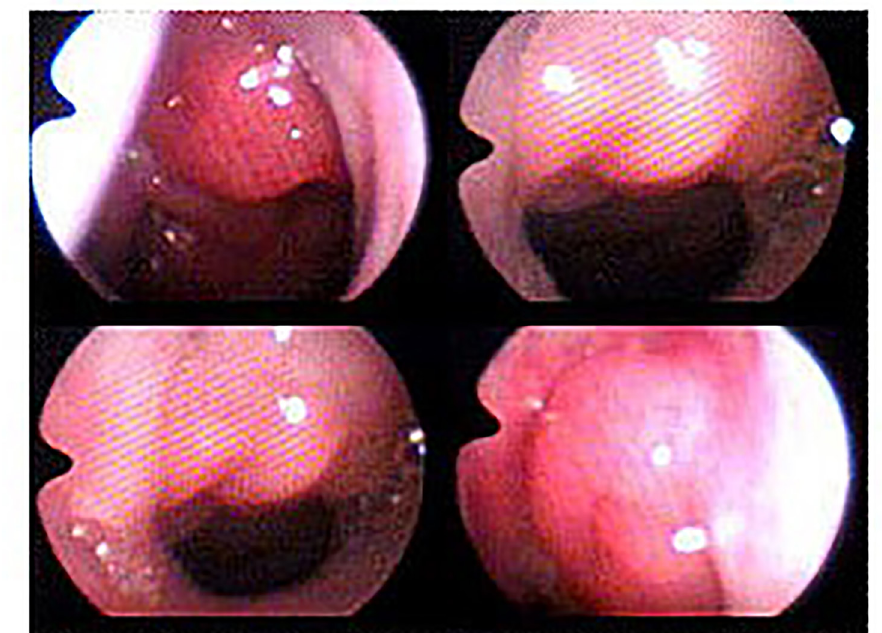
Figure 2 - Choana nasal endoscopic view – Grades I (up to 25% of choana obstruction), II (25% to 50% of choana obstruction) , III (50% to 75% of choana obstruction) and IV (more than 75% of choana obstruction) - from left to right and from top to